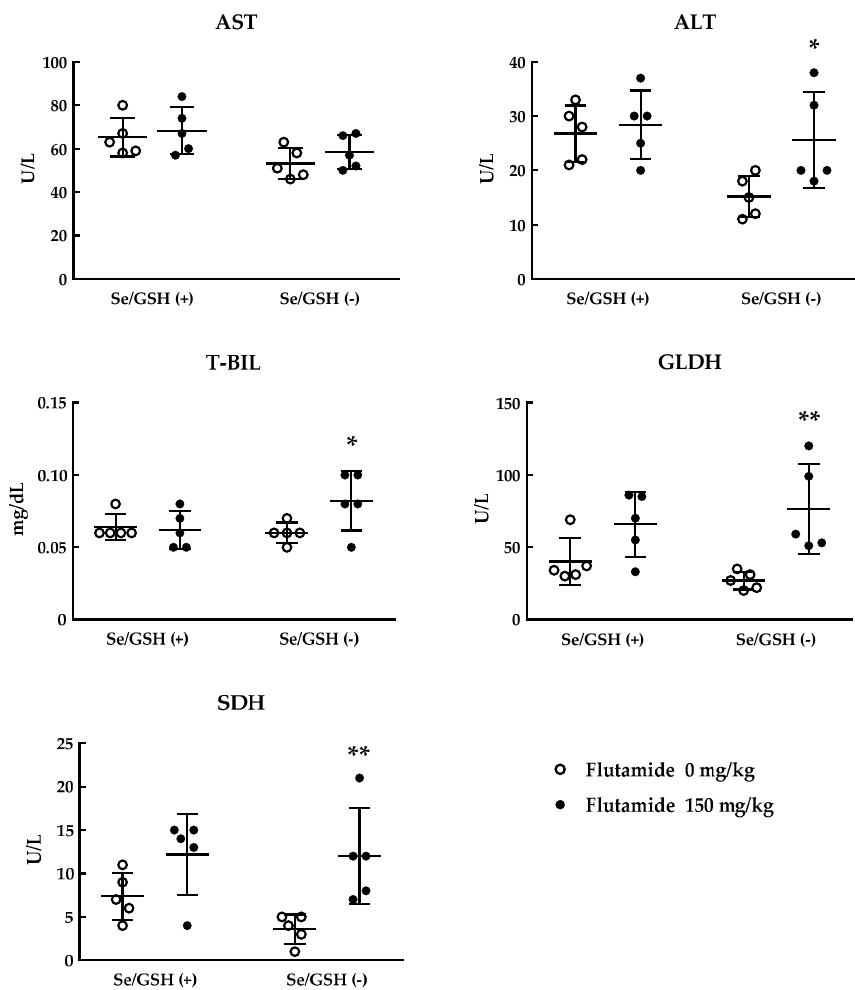
Figure 4. Liver function parameters in the Se/GSH ( − ) and (+) rats treated with flutamide. All data and mean ± S.D. are presented with 5 determinations. * p < 0.05, ** p < 0.01 (Student’s t-test). Se/GSH (+): normal rats, Se/GSH ( − ): Se/GSH-depleted rats.